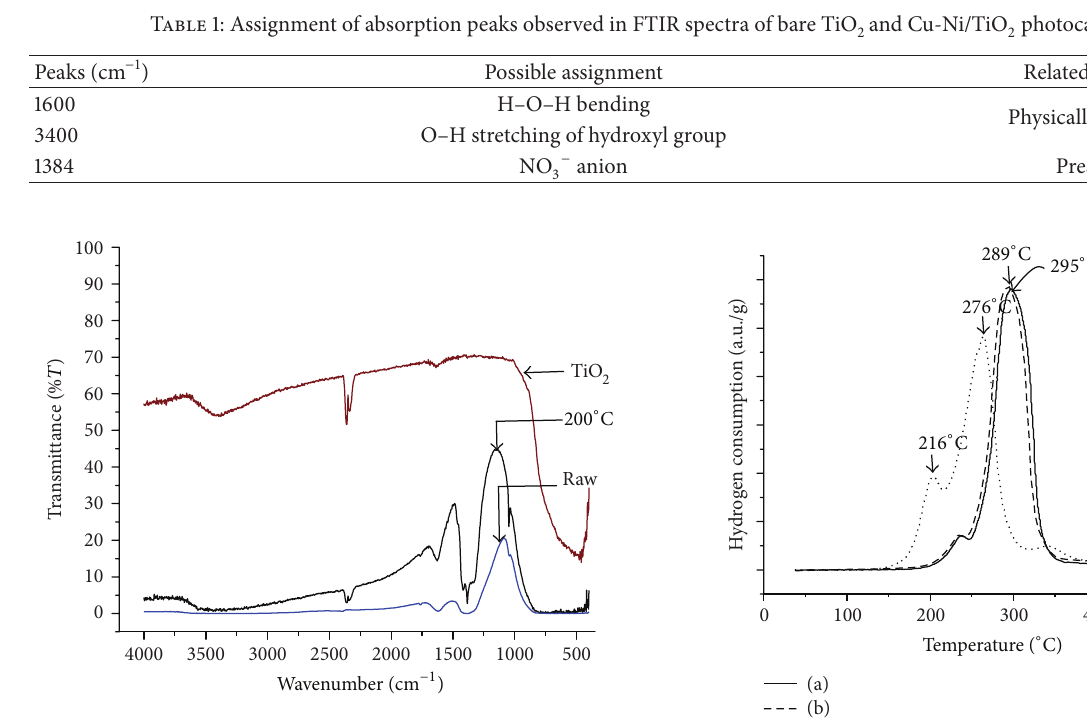
Figure 3: FTIR spectra of bare TiO 2 and Cu-Ni/TiO 2 photocatalysts (raw and calcined at 200 ∘ C). Table 2: Summary of the hydrogen consumption and the reduction temperature of the photocatalysts.